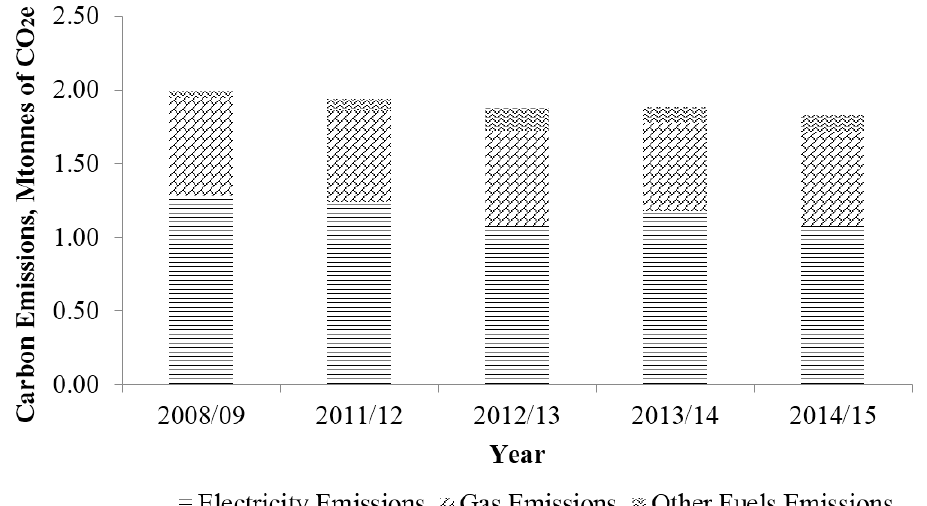
Figure 1. Variation of CO 2 emissions of England’s HE sector [4].